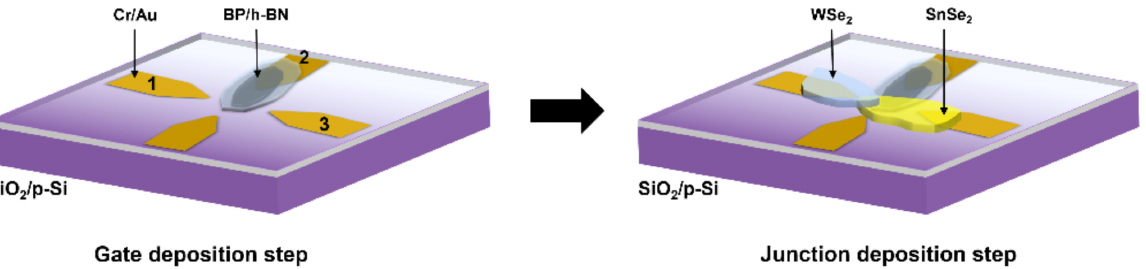
Figure 1. Schematic representation of the fabricated WSe 2 /SnSe 2 van der Waals heterostructure-based gated tunnel field-effect